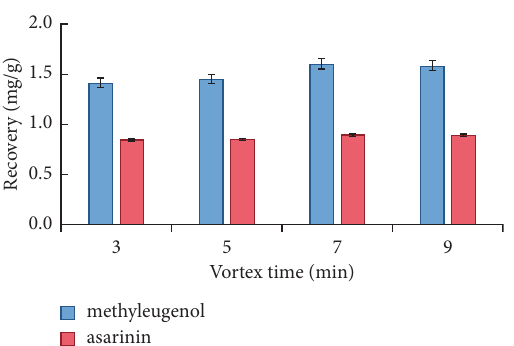
Figure 8: Effect of ultrasonic time, extraction conditions: sample amount, 50mg; molar ratio, 1:2; DES volume, 1.5 mL; ultrasonic temperature, 60 ° C; and ultrasonic time, 30min. Table 5: Analysis of variance of quadratic regression equation of Box–Behnken response surface.